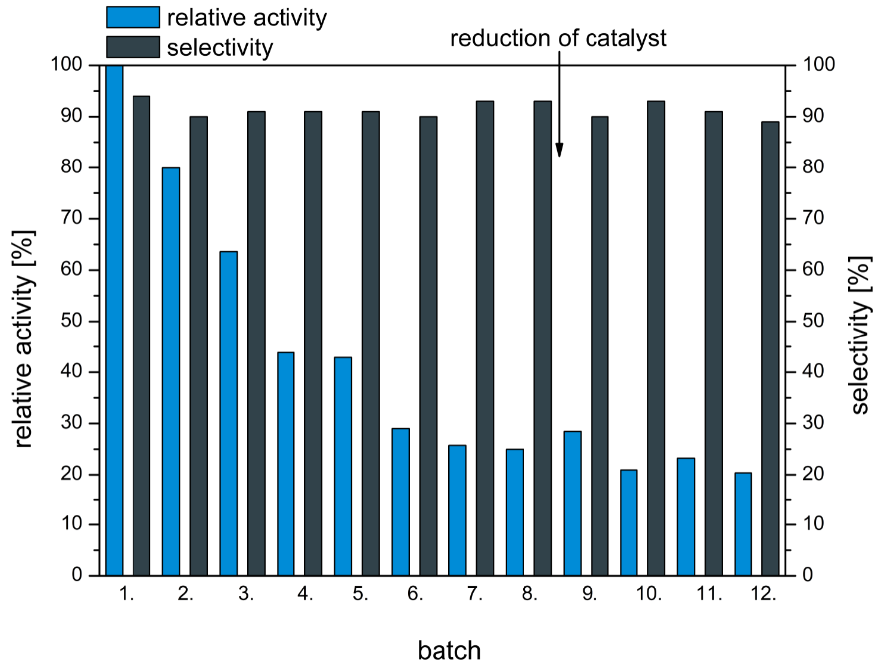
Figure 4. Long-term stability of 0.1 wt% AuPt(9:1)/CeO 2 in the oxidation of MEG to GA. Reaction conditions: 20 wt% MEG, 75 ◦ C, 25 g/L catalyst, pH 10.5, 7 bar O 2 (relative activity (%) = activity conditions: 20 wt% MEG, 75 °C, 25 g/L catalyst, pH 10.5, 7 bar O 2 (relative activity (%) = activity of